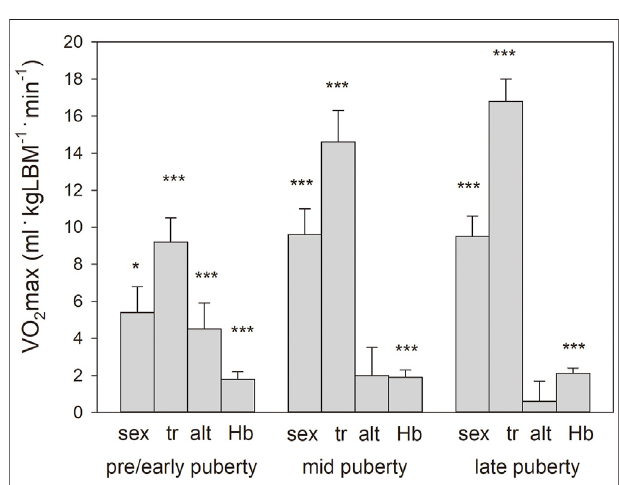
FIGURE 3 | Main effects with standard errors calculated by multiple regression analysis separately for the pooled puberty stages for sex (boys vs girls), training status (tr, trained vs. untrained), altitude (alt, 2,600 m vs. 1,000 m),andHbmass(gkgLBM − 1 )onVO 2 maxnormalizedtoleanbody mass.Becauseofthe interaction inthemid-and late puberty groups, the main effects for sex and Hbmass were calculated independently. Signi fi cance of effects: * = p < 0.05, *** = p < 0.001.